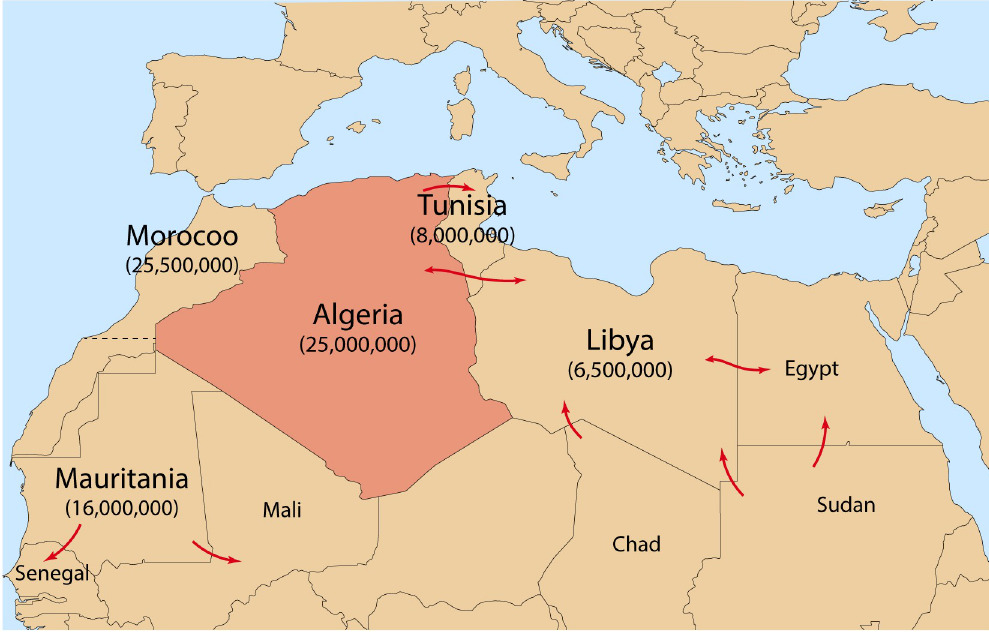
Fig 2. Major pathways of traditional movement of small ruminants in the Maghreb region. Pathways are indicatedby red arrows and 2015 estimated populationsof sheep and goats are indicatedin brackets beneath Maghreb regioncountry names. Modifiedfrom ([4,